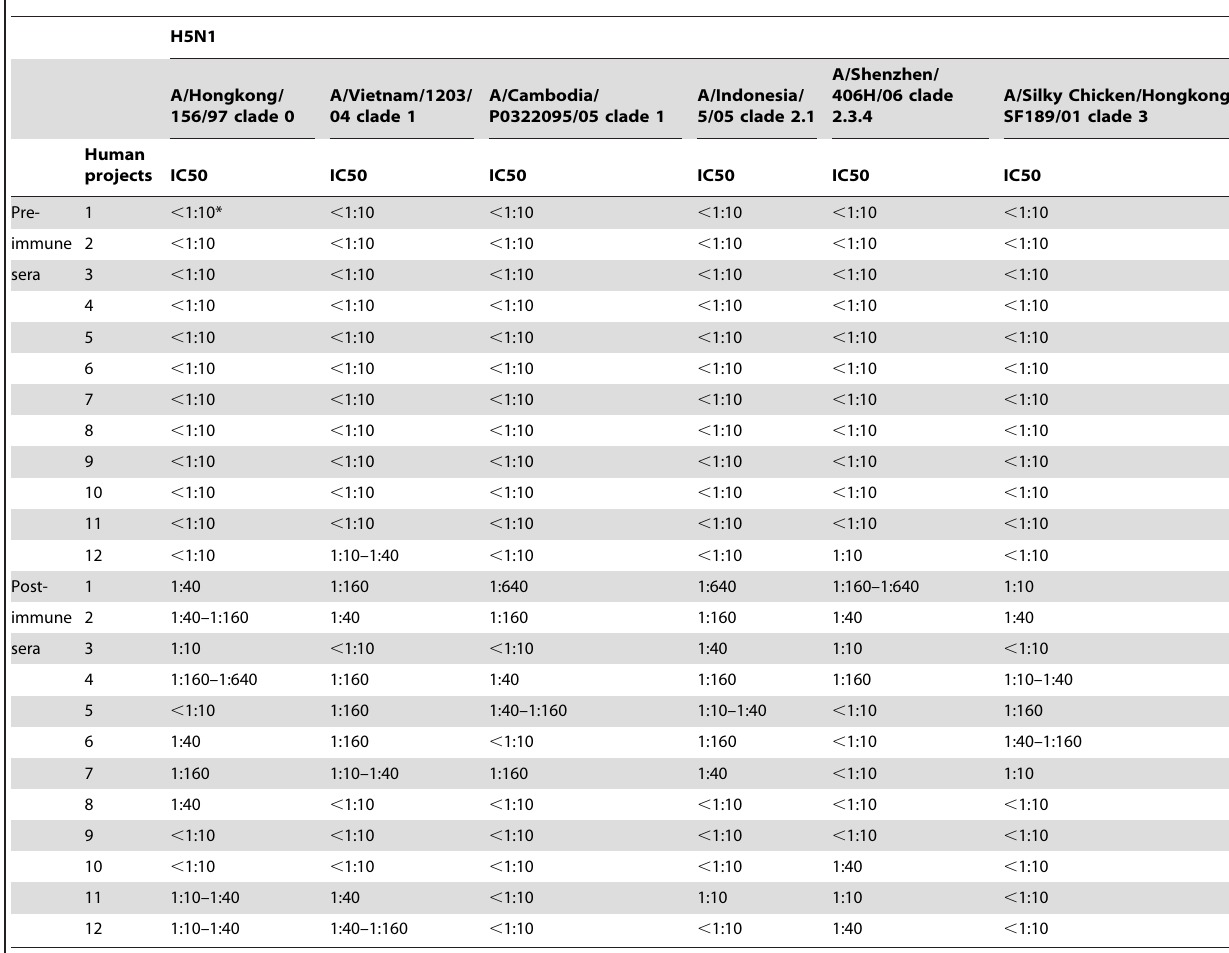
Table 2. Neutralizing antibody titers against H5N1 in pre- and post-immune sera measured by PN (entry)